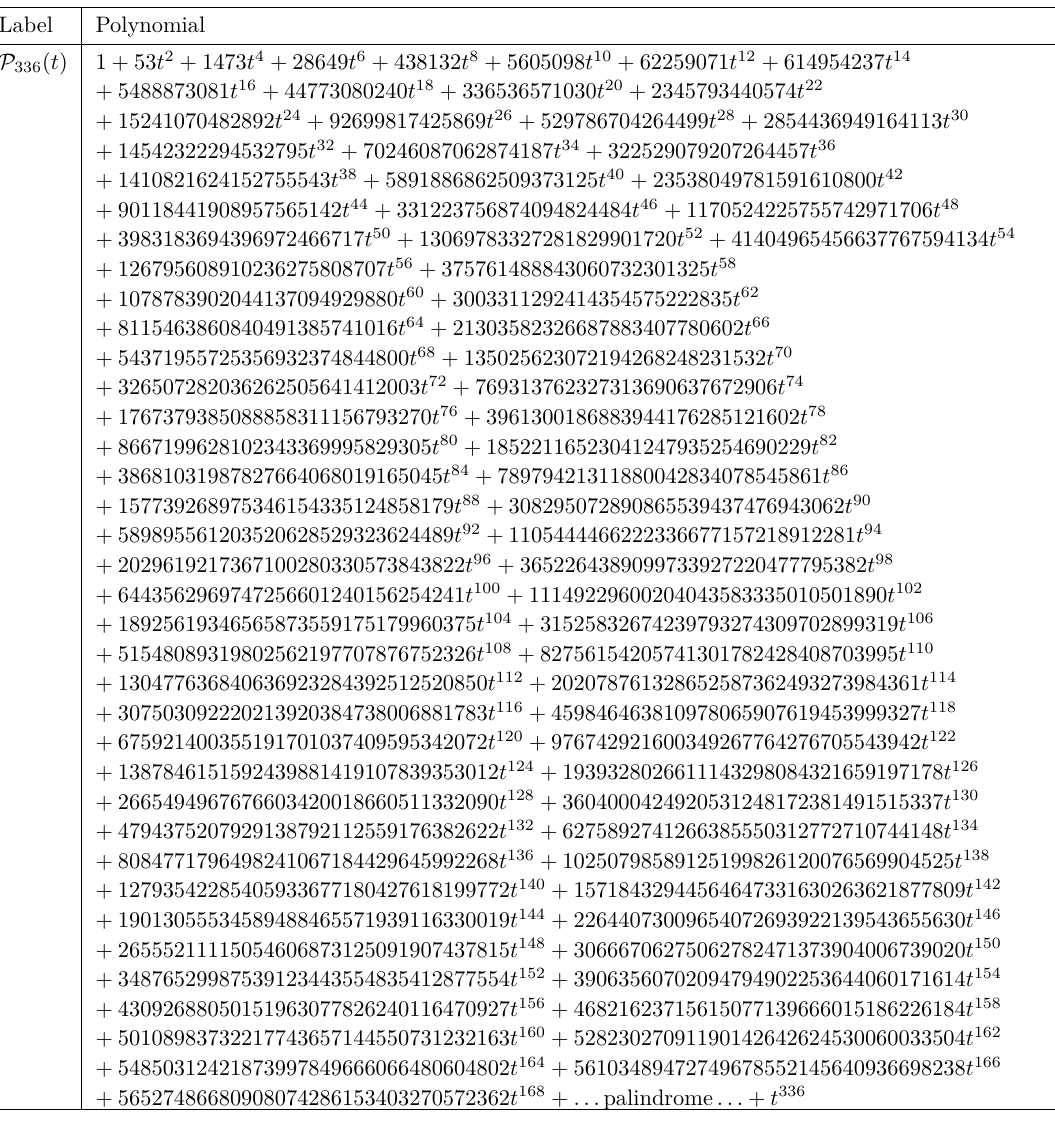
Table 43. Palindromic polynomials